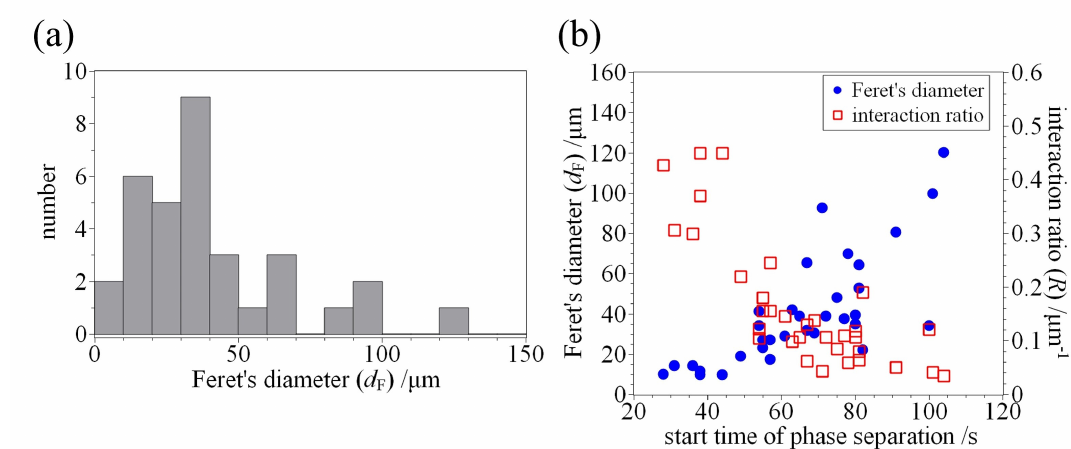
Figure 4. ( a ) Histogram plot of Feret’s diameter ( d F ) of HPC droplets (droplet size, n = 33). The value of Feret’s diameter is 34 ± 27 µ m (median ± SD); ( b ) Relationship between start time of phase separation and d F of HPC droplets/interaction ratio between HPC and 1,2-dipalmitoyl-sn- glycero-3-phosphocholine (DPPC) ( R